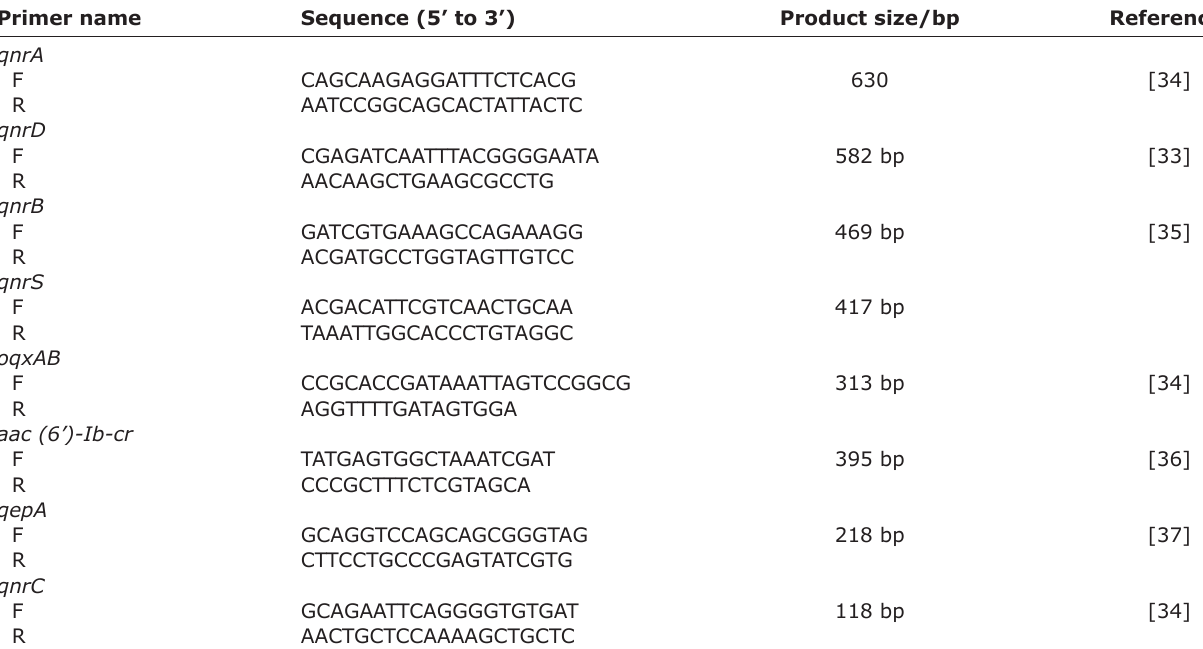
Table-1: Primer sequences for the eight plasmid-mediated resistance gene determinants.